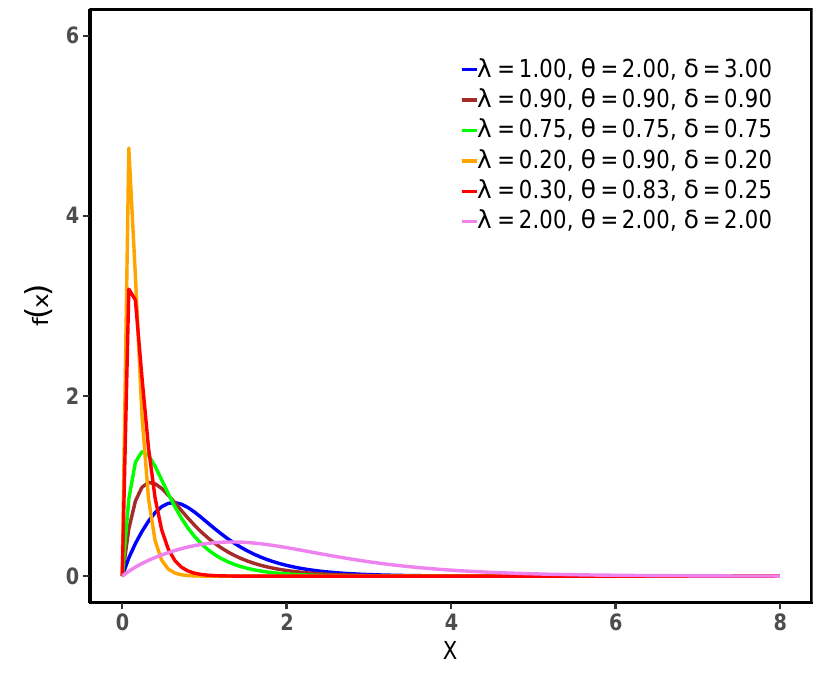
Figure 1. Plots of the pdf of the HEB